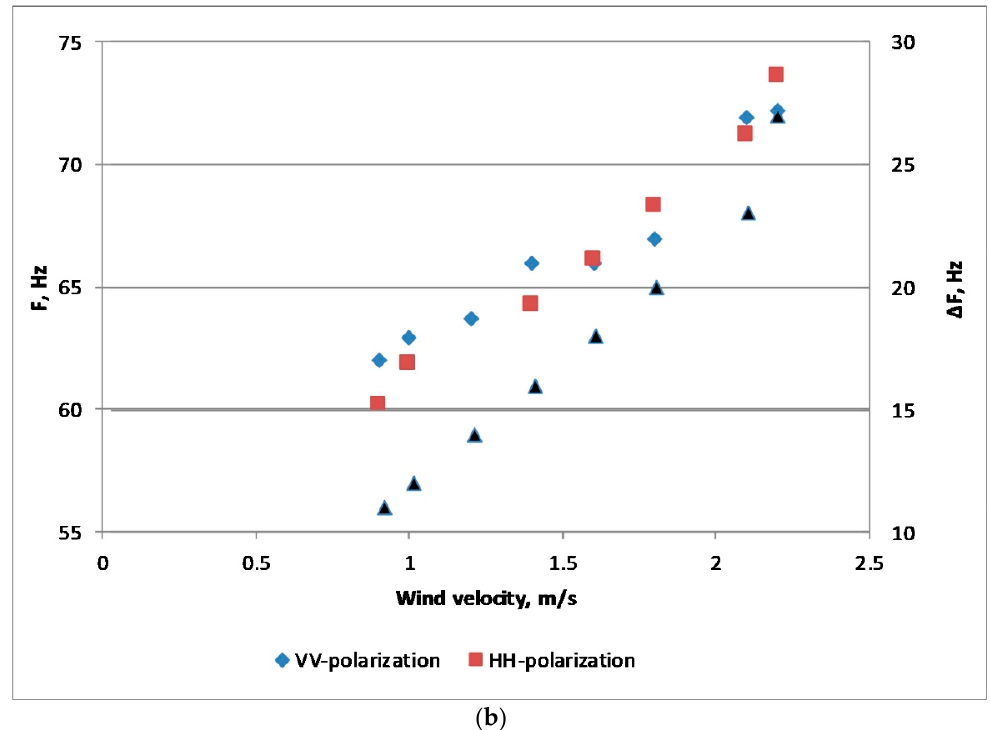
Figure 7 . Radar Doppler spectra ( a ) at different wind velocities. Doppler shifts at VV and HH polarizations and the Doppler spectrum width (black triangles) at VV polarization ( b ) as functions of wind velocity.